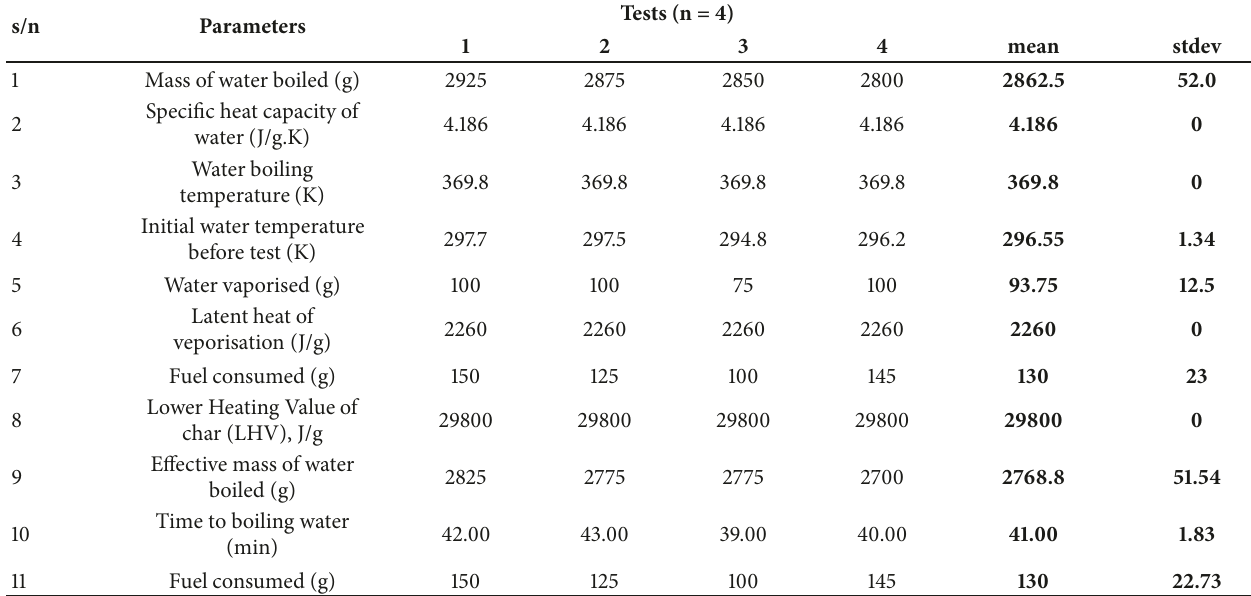
Table 3: Data from WBT ( see Figure S5 in the Supplementary Materials for comprehensive analysis).